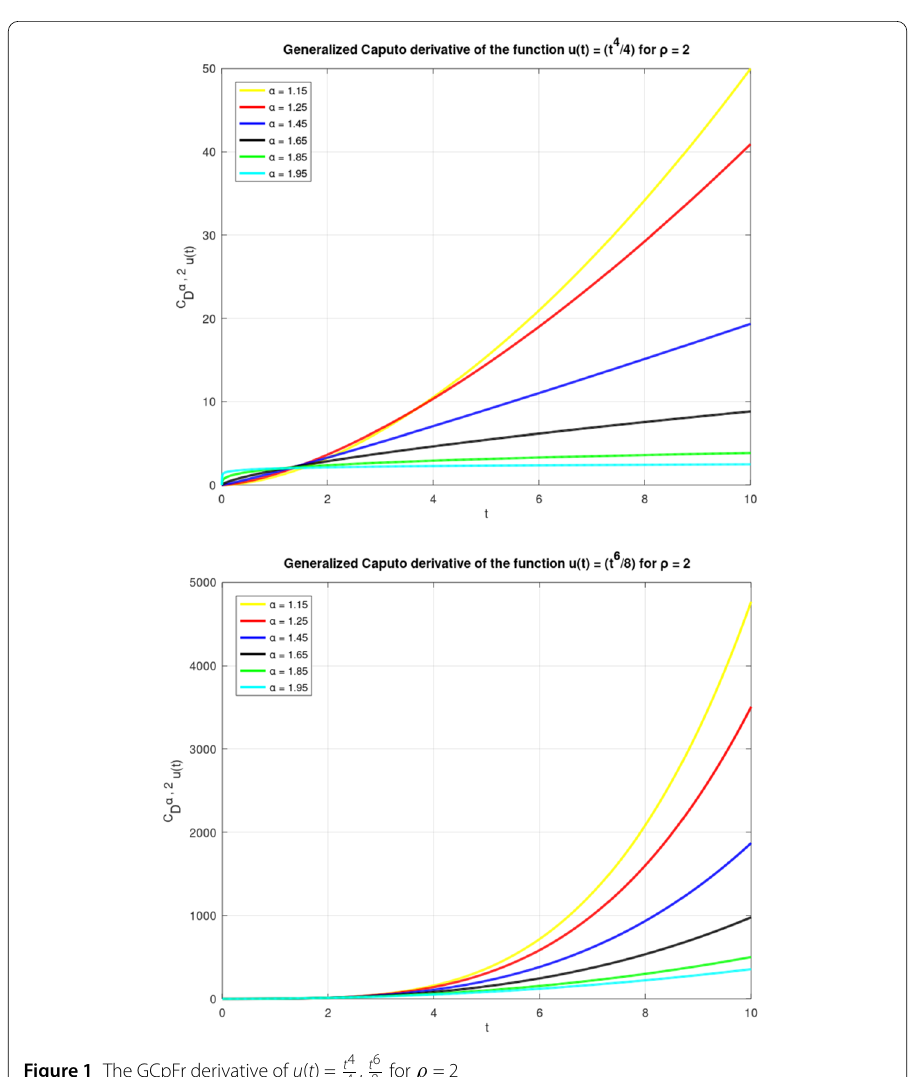
Figure 1 The GCpFr derivative of u ( t ) = t 4